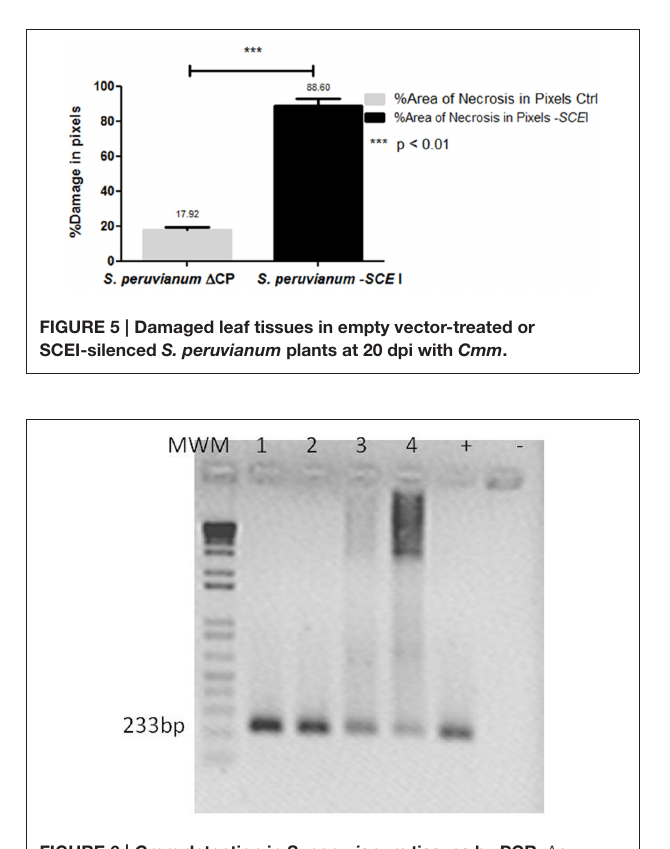
FIGURE 6 | Cmm detection in S. peruvianum tissues by PCR. An amplicon of 233 bp was obtained using Cel- A primers por Cmm detection at 10 and 20 dpi. Lanes show PCR products shown with template of: (1) leaf tissue of SCE I-silenced S. peruvianum at 10 dpi, (2) leaf tissue of SCE I-silenced S. peruvianum at 20 dpi, (3) leaf tissue of empty vector treated S. peruvianum at 10 dpi, (4) leaf tissue of empty vector treated S. peruvianum at 20 dpi. Plasmid of pGEM T-Easy with Cel - A fragment. (-) Negative control. 100ng of DNA were taken for each